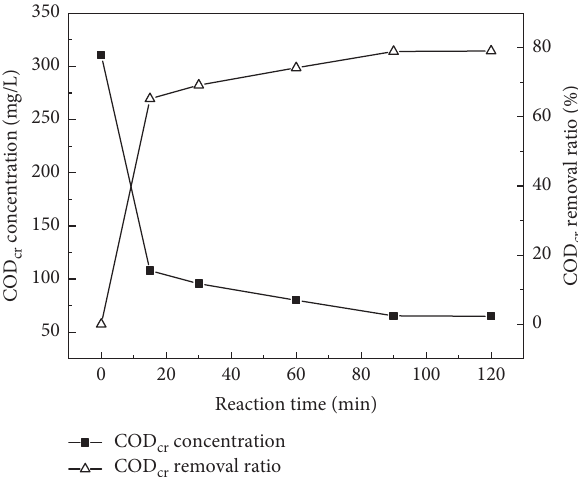
Figure 8: Effect of reaction time on removal of COD oxidation.